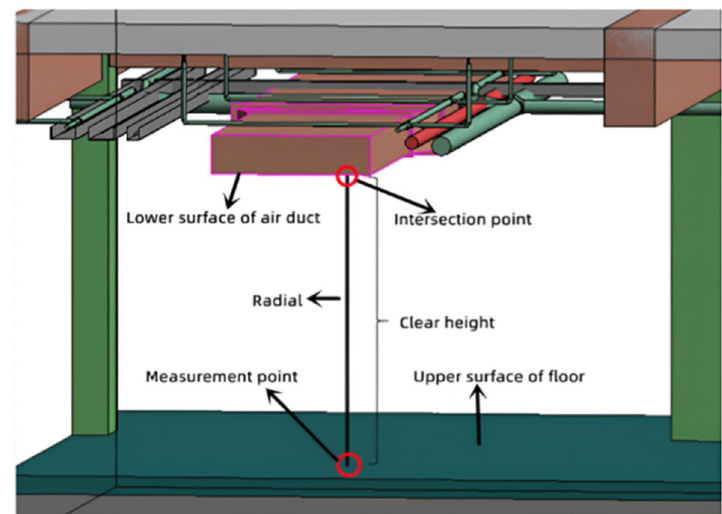
Fig. 4 Schematic diagram of ray algorithm